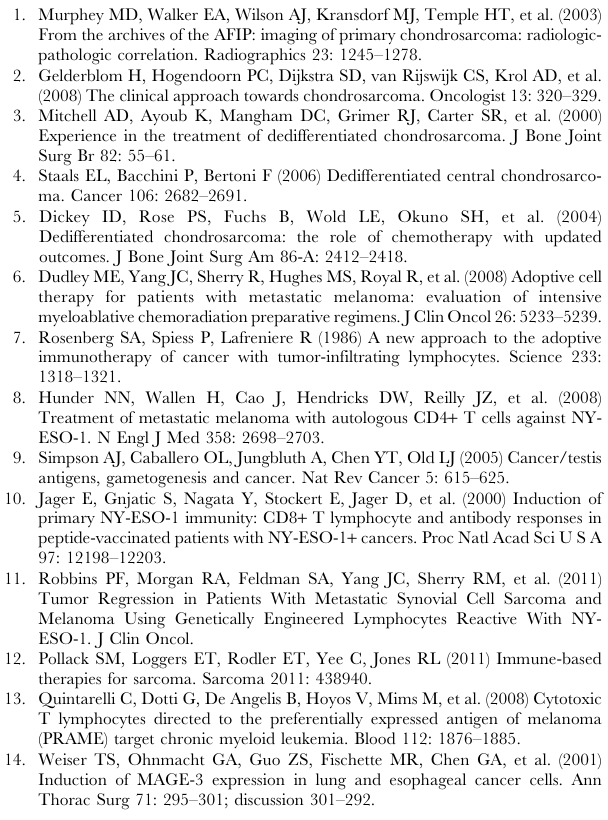
Figure S2 5-Aza-dC treated cells from the JJ or FS cells lines were incubated with NY-ESO-1 or PRAME specific effectors along with un-pulsed (control) or peptide pulse T2 lymphocytes. Killing of the chromium labeled tumor